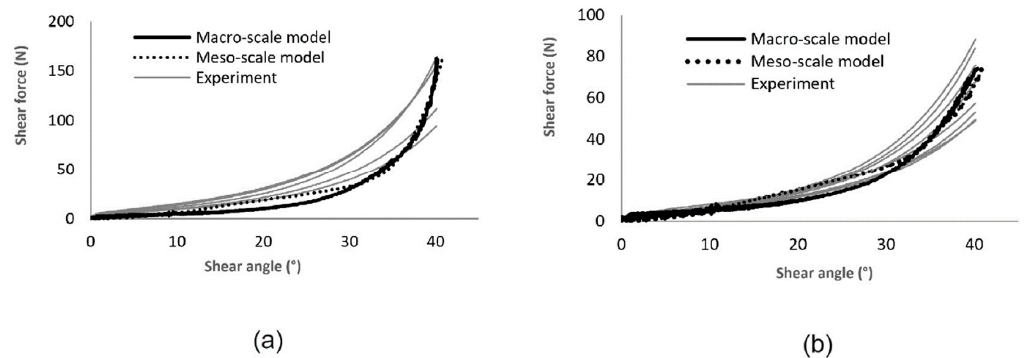
Figure 11. Comparison of shear force-shear angle curves between simulation and experiment of ( a ) Variant 1 (five samples) and ( b ) Variant 2 (six samples).